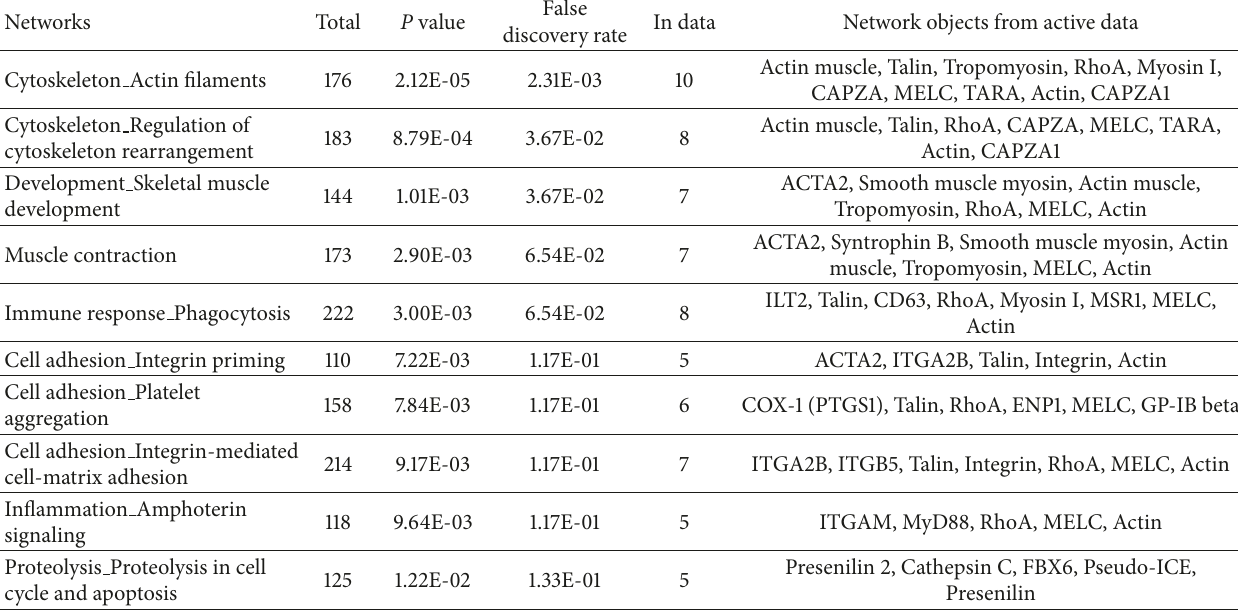
Table 3: Biological process networks for 250 genes whose expression in peripheral CD4+ cells was positively correlated with serum IL-8 concentration.